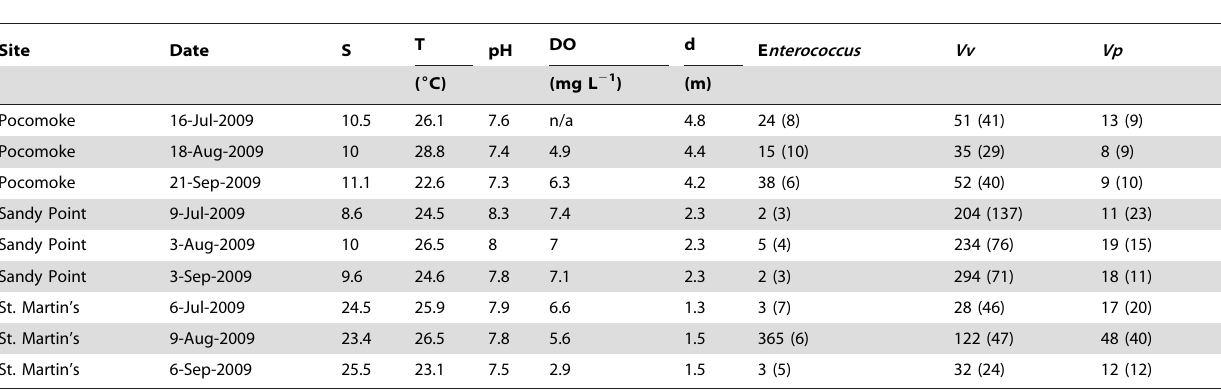
Table 3. Physical, chemical and bacterial water quality including salinity (S), temperature (t), dissolved oxygen (DO), depth (d), and Average concentration of Enterococcus (geometric mean CFU 100 mL 2 1 ), V. vulnificus (Vv) , and V. parahaemolyticus (Vp) (CFU mL 2 1